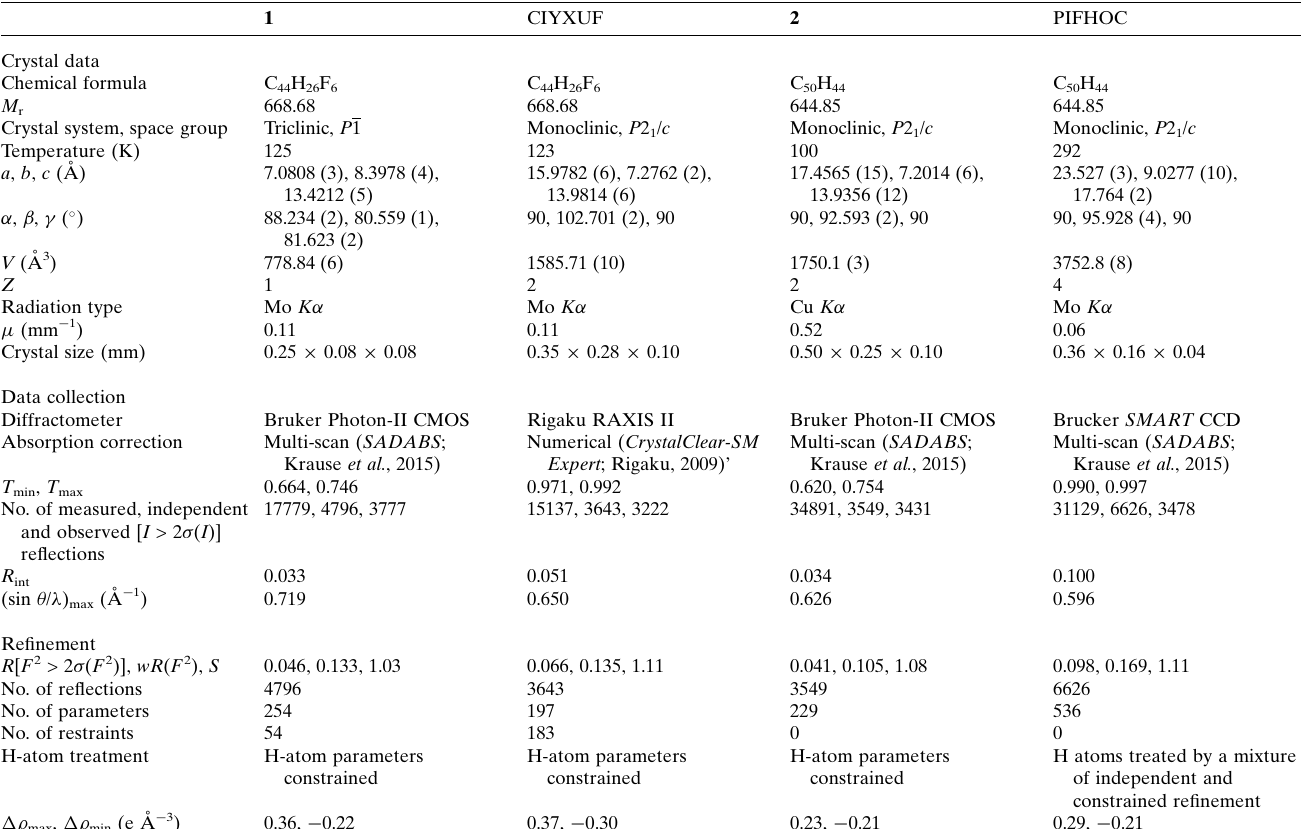
Table 1 Experimental details.